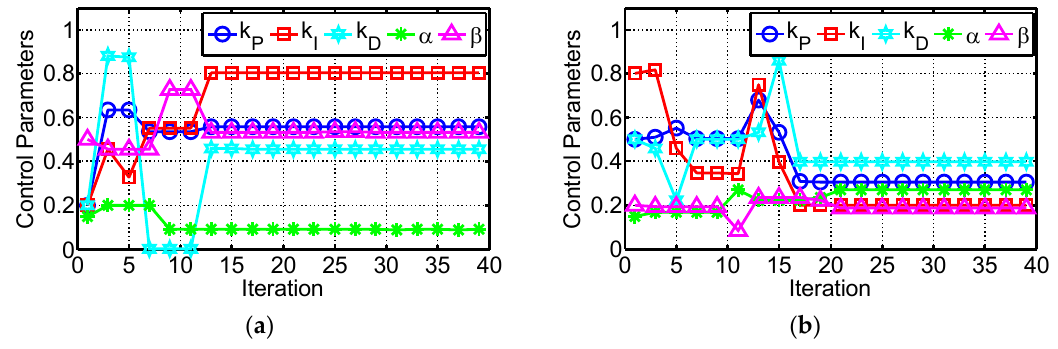
Figure 8. Evolutions of the self-tuning control parameters: ( a ) normalized values in Case 1; and ( b ) normalized values in Case 2.